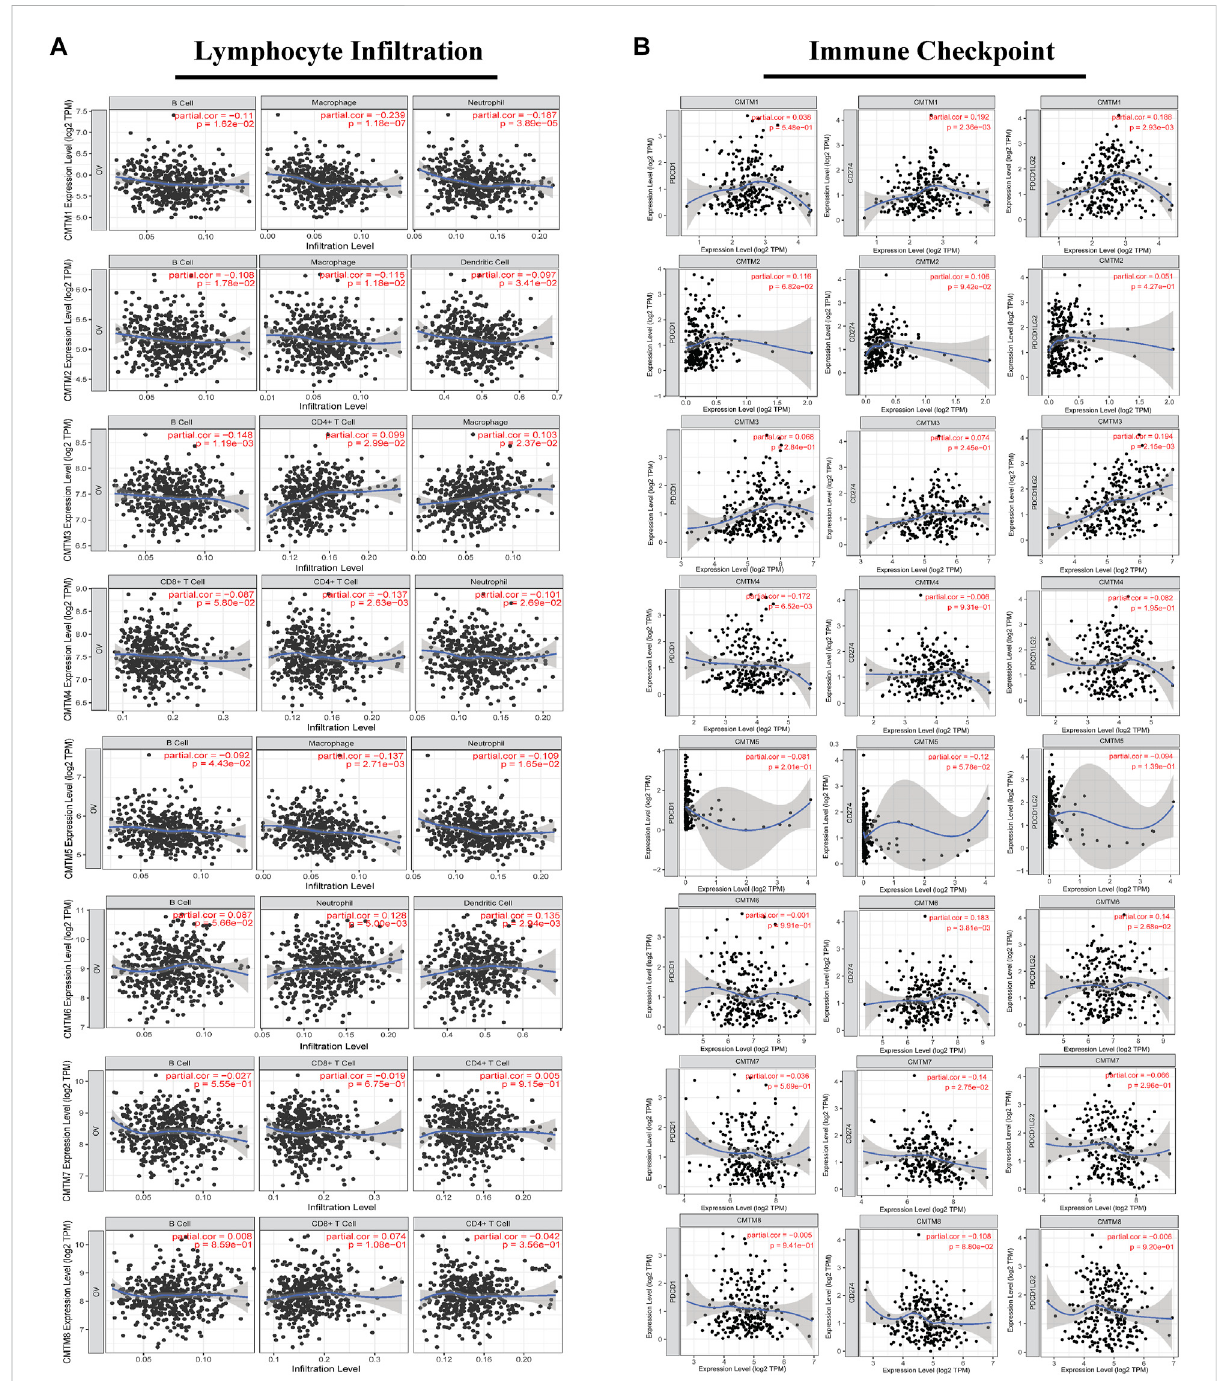
FIGURE 8 The correlation between the expression level of each member of the CMTM family and the degree of immune in fi ltration of multiple immune cells or the expression of immune checkpoint genes in ovarian cancer tissues. (A) The correlation between the expression level of each member of the CMTM family in ovarian cancer tissues and the degree of immune in fi ltration of a variety of immune cells, including B cells, CD8+T cells, CD4+T cells, macrophages, neutrophils, and dendritic cells. (B) The correlation between the expression level of CMTM and the genes PDCD1, CD274, andPDCD1LG2that encode theimmunecheckpoints ofPD1,PDL1,and PDL2.Spearman ’ smethod wasusedfor correlation analysis.Partial. cor > 0 was considered a positive correlation. Partial. cor < 0 was considered a negative correlation. p < 0.05 was considered statistically signi fi